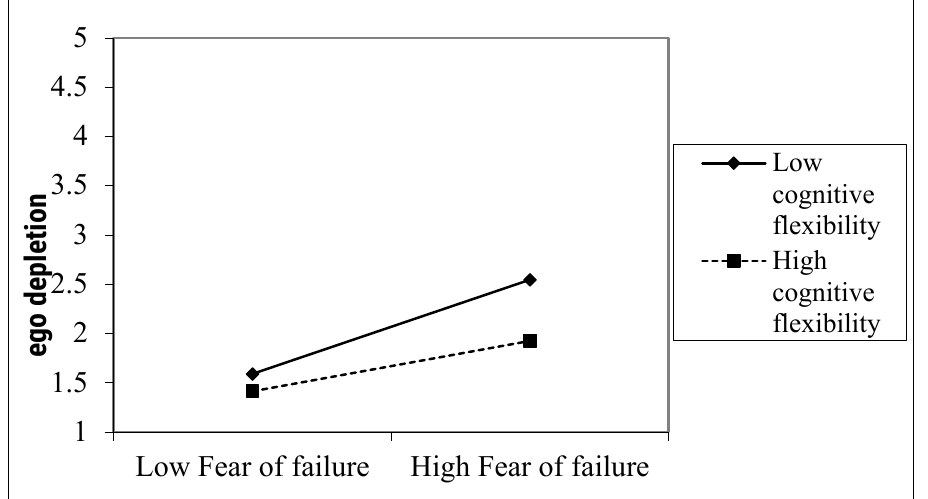
Figure 2. Interaction of the fear of failure and cognitive flexibility on ego depletion.